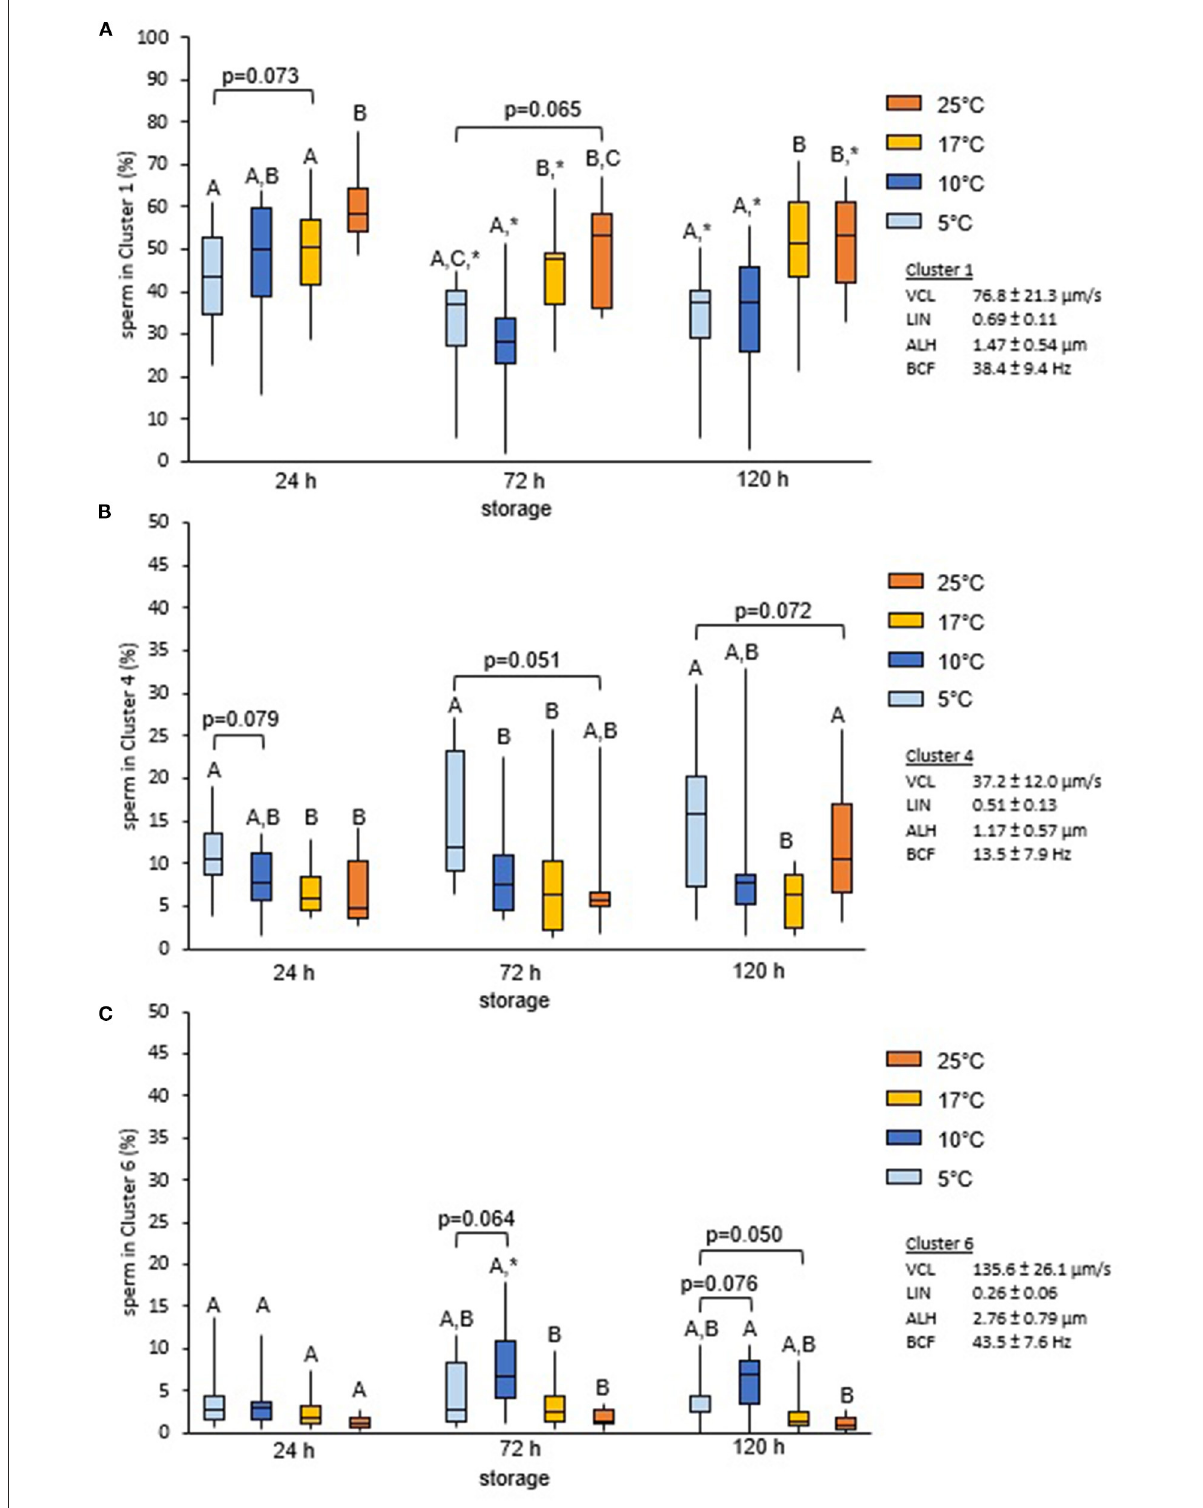
FIGURE4 Change in motile sperm subpopulations with storage times and temperature. Change in size of selected cluster in relation to semen storage temperature and time. Spermatozoa were stored in Beltsville Thawing Solution at 25, 17, 10, or 5 ◦ C for 24, 72, and 120h ( n = 7 boars). Results represent data for Cluster 1 (A) , Cluster 4 (B) , and Cluster 6 (C) . Different capital letters indicate significant differences between storage temperatures at a given storage time ( P < 0.05). An asterisk ( * ) indicates a significant change after 72 or 120h storage as compared to 24h for a given storage temperature ( P <